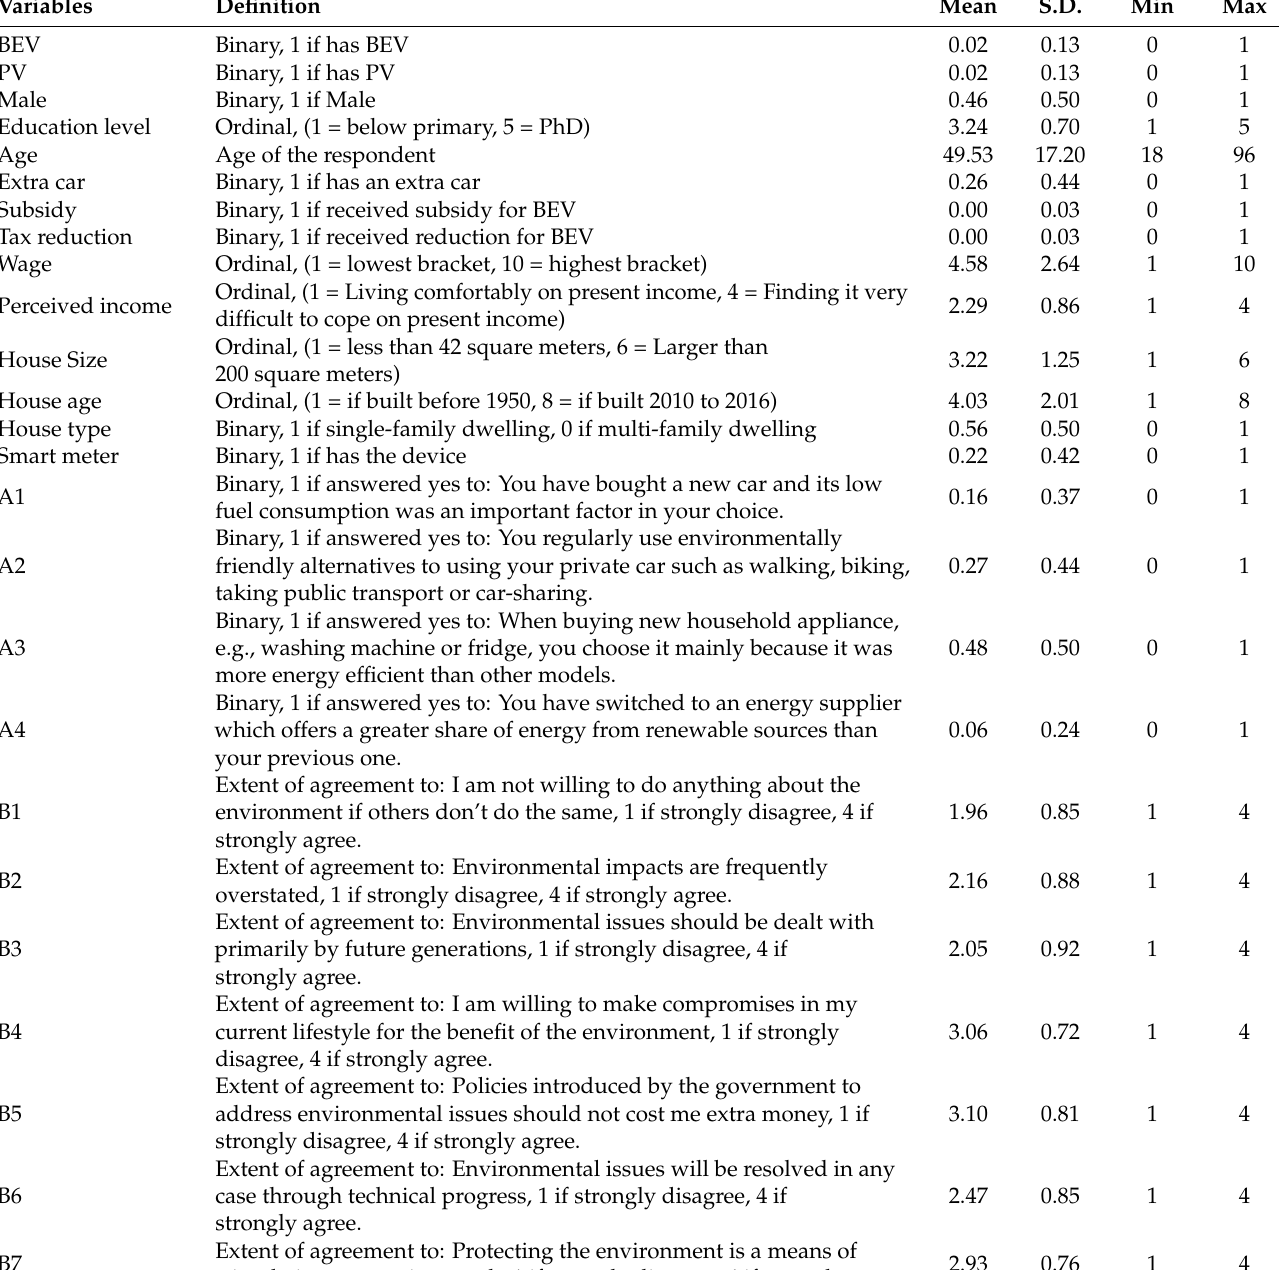
Table 2. Variables’ description and summary